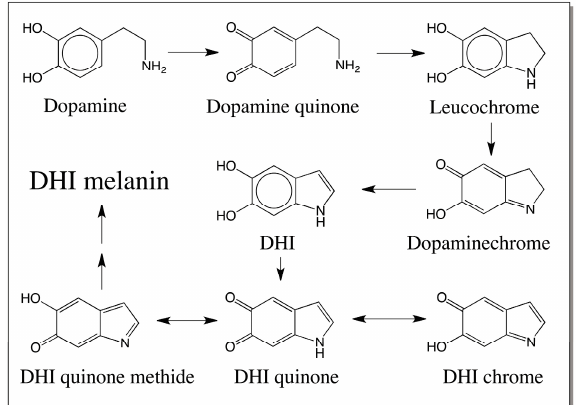
Figure 7. Melanin biosynthesis from dopamine. Tyrosinase or other oxidative enzymes/reactants will convert dopamine to dopaminequinone. Intramolecular cyclization to leucochrome and further oxidation of the leucochrome produces the dopaminechrome. Dopaminechrome is converted to DHI